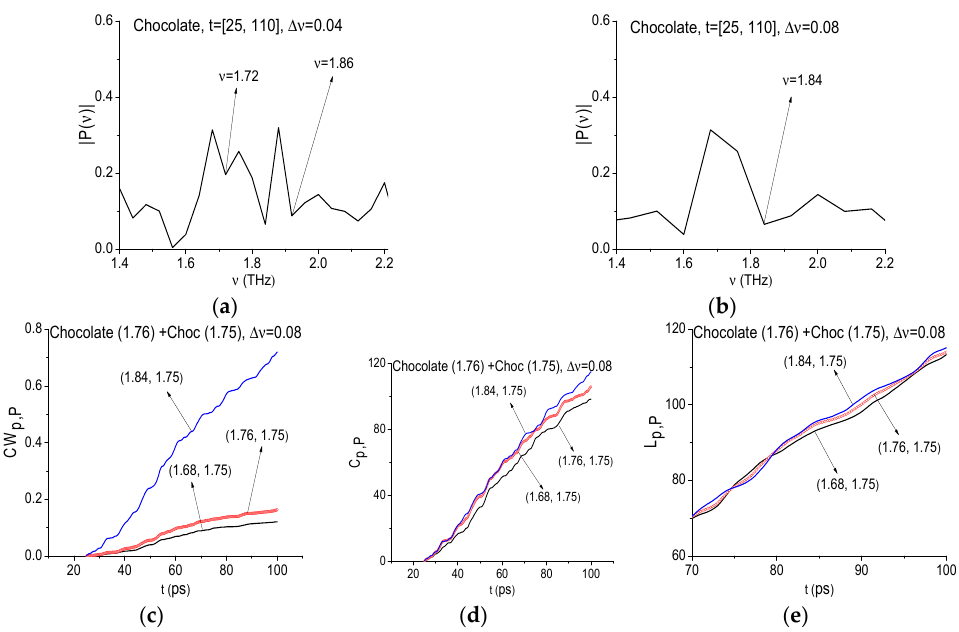
Figure 15. Signal Chocolate spectrum in the frequency range ν = [1.4, 2.2] THz calculated in the time interval t = [25, 110] ps with the spectral resolution Δ ν = 0.04 THz ( a ); 0.08 THz ( b ). The ICC’s CW p,P ( c ), C p,P ( d ), L p,P ( e ), calculated for frequency ν = 1.76 THz for the signal Chocolate and Choc10 as the standard one.